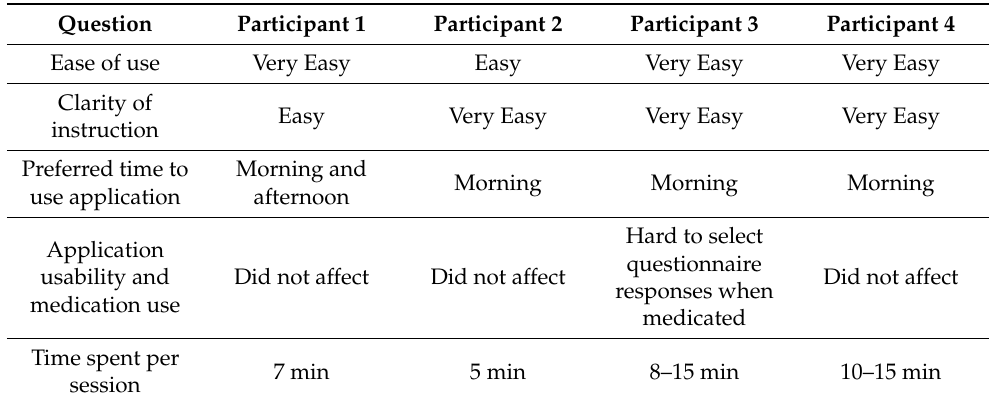
Table 6. Application usability responses.